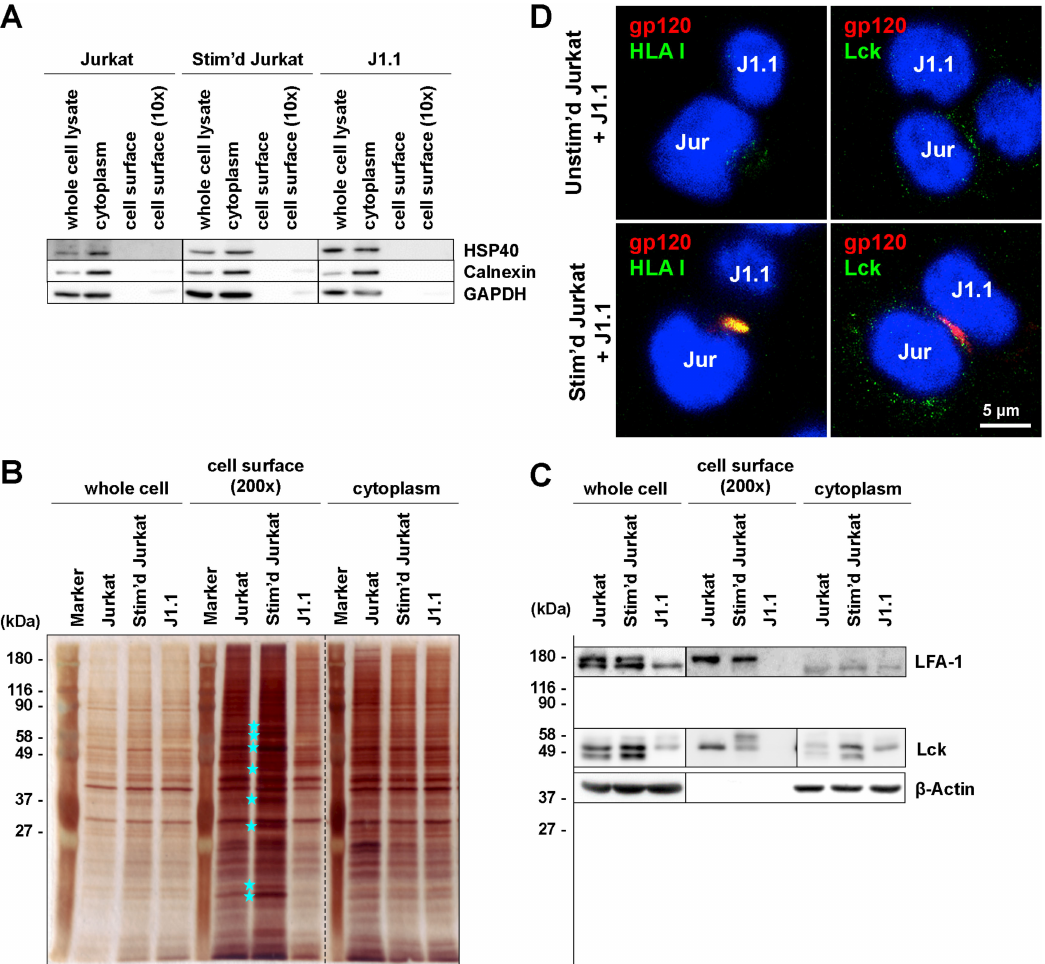
Figure 6. Isolation of the cell surface protein fraction and their cellular distribution. Cell surface protein fractions were isolated from the unstimulated and stimulated Jurkat cells, and J1.1 cells. The cell surface protein was biotinylated and a ffi nity purified with avidin beads. ( A ) Marker proteins in the cell fractions isolated from the unstimulated and stimulated Jurkat cells, and the J1.1 cells. The whole cell, flow through, and a ffi nity purified fractions were subjected to western blotting using anti-HSP40, anti-Calnexin and anti-GAPDH Abs. The 1 × and 10 × input were resolved on SDS-PAGE. ( B ) Silver staining of the cell fractions isolated from the unstimulated and stimulated Jurkat cells, and J1.1 cells. Stars indicate protein bands enriched in the cell surface fraction of the stimulated Jurkat cells, as compared with those of the unstimulated Jurkat cells. The 1 × and 200 × input were resolved on SDS-PAGE. ( C ) LFA-1 expression on the cell surface. The fractions shown in (B) were subjected to western blotting using anti-LFA-1 α and anti- β -actin mAbs, and anti-Lck Ab. ( D ) J1.1 cells were prelabeled with CellTracker and were cocultured with unstimulated or stimulated Jurkat cells with cell contact. At 3 days post coculture, the cells were immunostained with anti-HIV-1 gp120 Ab (red) and anti-HLA I mAb or anti-Lck Ab (green). Representative images were shown. Scale bar, 5 µ